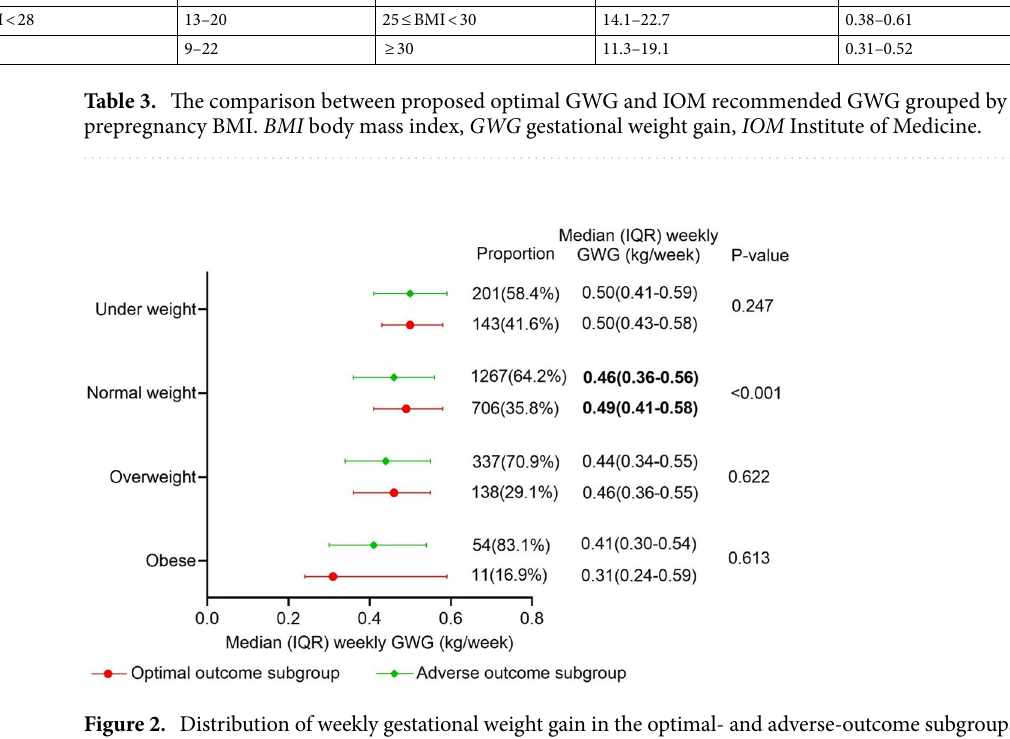
Figure 2. Distribution of weekly gestational weight gain in the optimal- and adverse-outcome subgroups. P < 0.05 was considered statistically significant. GWG gestational weight gain; IQR interquartile